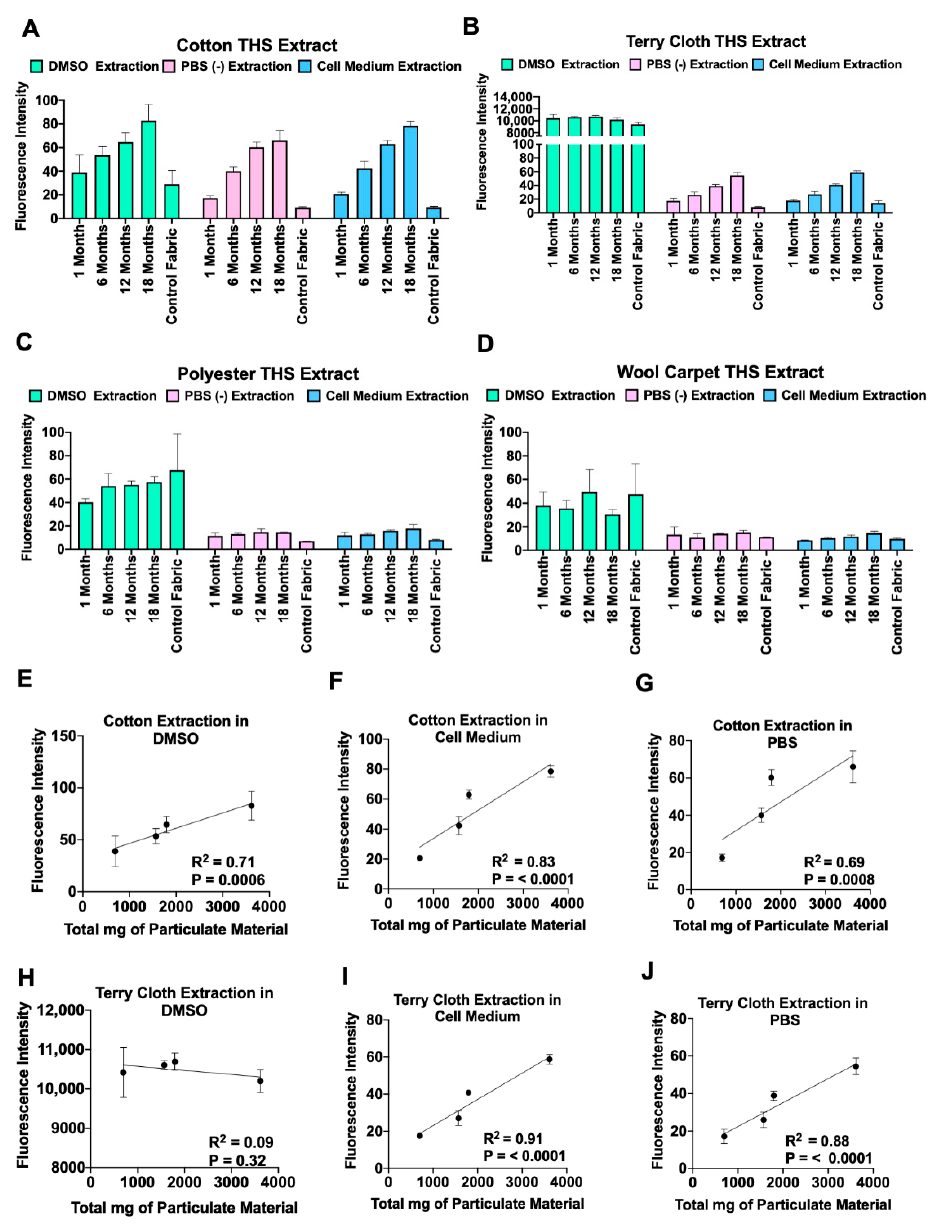
Figure 2. Fluorescence measurements of THS extracts showing that the extracts were autofluorescent. ( A – D ) Excitation wavelength 360/40 with emission at 460/40 detected THS residue in fabrics extracted in DMSO, PBS, and cell medium. ( E – J ) Fluorescence intensity was proportional to the amount of THS exposure received by the fabrics extracted in PBS and cell medium but not extracts in DMSO.